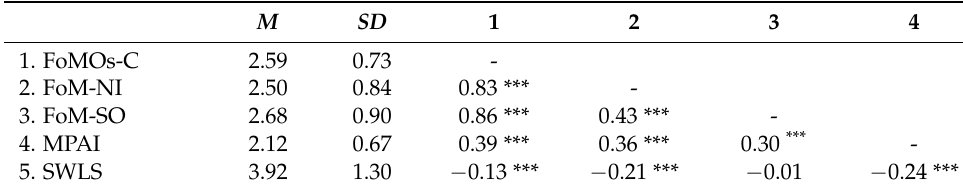
Table 3. The means, standard deviations, and correlations among the scales.